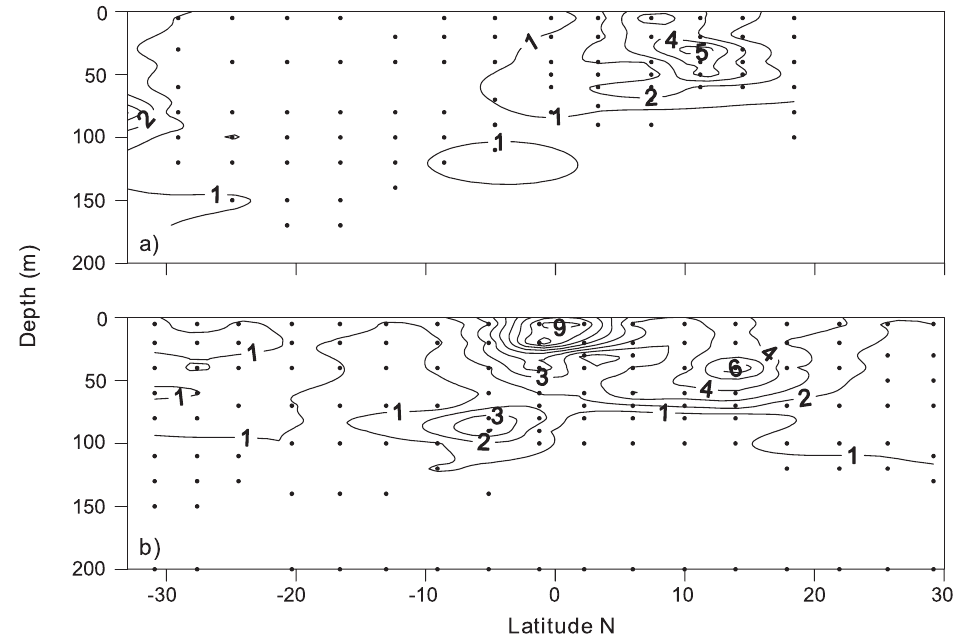
Fig . 5. – Latitudinal distribution of total primary production (mg C m -3 d -1 ). a) Trynitrop 2007; b) Trynitrop 2008.